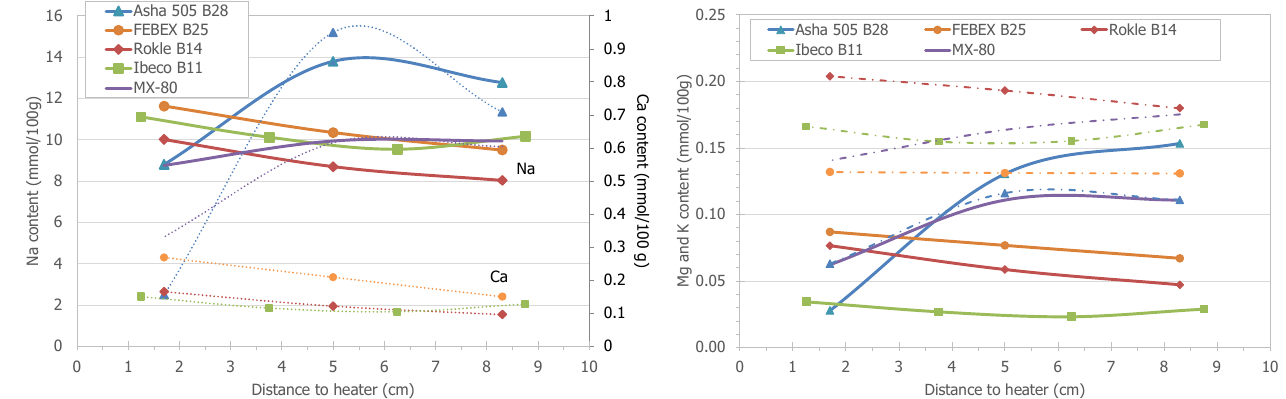
Figure 16. Cation distribution as a function of the heating contact obtained from leaching tests (in mmol/100 g). Reference data for chloride and sulfate are given for comparison.